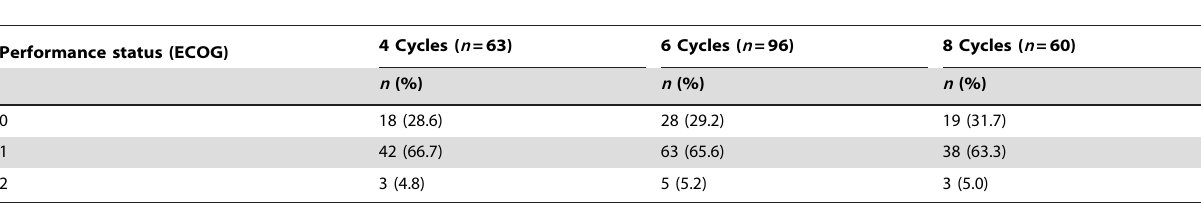
Table 4. Performance status evaluation at the fourth cycle of treatment.